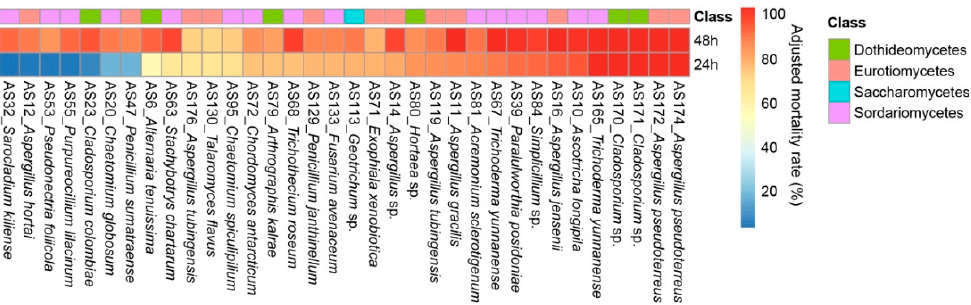
Figure 3. Toxicity of the crude extracts on peach aphid at a concentration of 10 mg/mL; only the 34 fungal strains with more than 70% of mortality after 48 h are shown here.